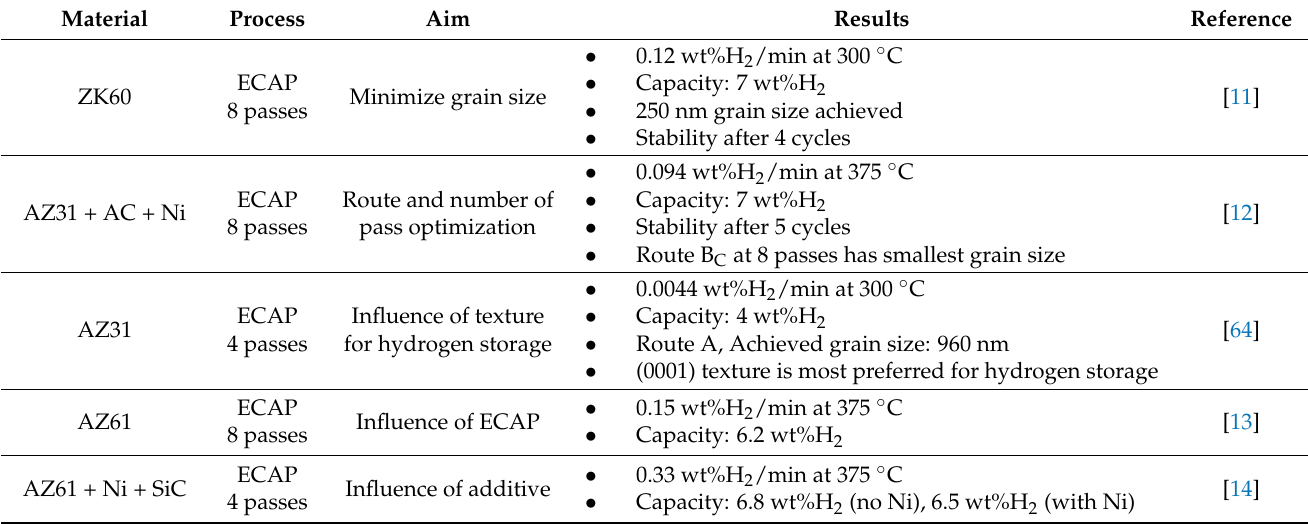
Table 2. Comparison of ECAP performance on different Mg alloys and composites.